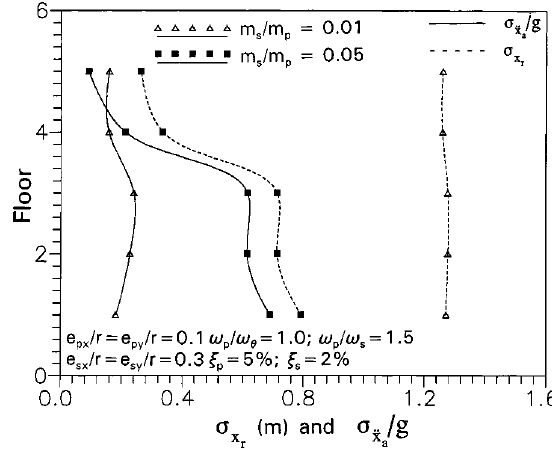
Fig. 12. Variation of (cid:27) x with storey height for various values of r e s x =r and e s y =r ; for m s =m p = 0.01; ! p =! s = 1.5; ! p =! (cid:18) = 1.0; e p x =r = e p y =r = 0 : 1; (cid:24) p = 5% and (cid:24) s = 2%.